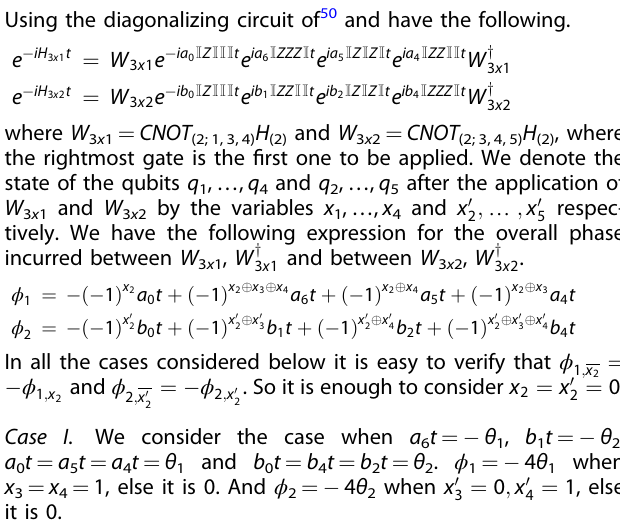
Fig. 4 Quantum circuit for e (cid:1) iH 3 y t and e (cid:1) iH 3 x 1 t . a – e : Circuit simulating e (cid:2) iH 3 y t ( a ) when a 1 t = − θ 1 , b 6 t = − θ 2 , a 2 t = a 3 t = a 7 t = θ 1 and b 3 t = b 5 t = b 7 t = θ 2 ; ( b ) with the coef fi cient values in ( a ), except here θ 1 = θ 2 ; ( c ) when a 1 t = a 2 t = a 3 t = a 7 t = θ 1 and b 3 t = b 5 t = b 6 t = b 7 t = θ 2 ; ( d ) when the coef fi cients are as in Equation 18; ( e ) Circuit with the coef fi cients in ( d ), except in this case h 2 = g 1 , h 3 = g 3 , h 1 = g 2 . f – h : Circuit simulating e (cid:2) iH 3 x 1 t ( f ) when a 6 t = − θ 1 , b 1 t = − θ 2 , a 0 t = a 5 t = a 4 t = θ 1 and b 0 t = b 2 t = b 4 t = θ 2 ; ( g ) when a 0 t = … = a 7 t = θ 1 and b 0 t = … = b 7 t = θ 2 ; ( h ) when the coef fi cients are as in Equation